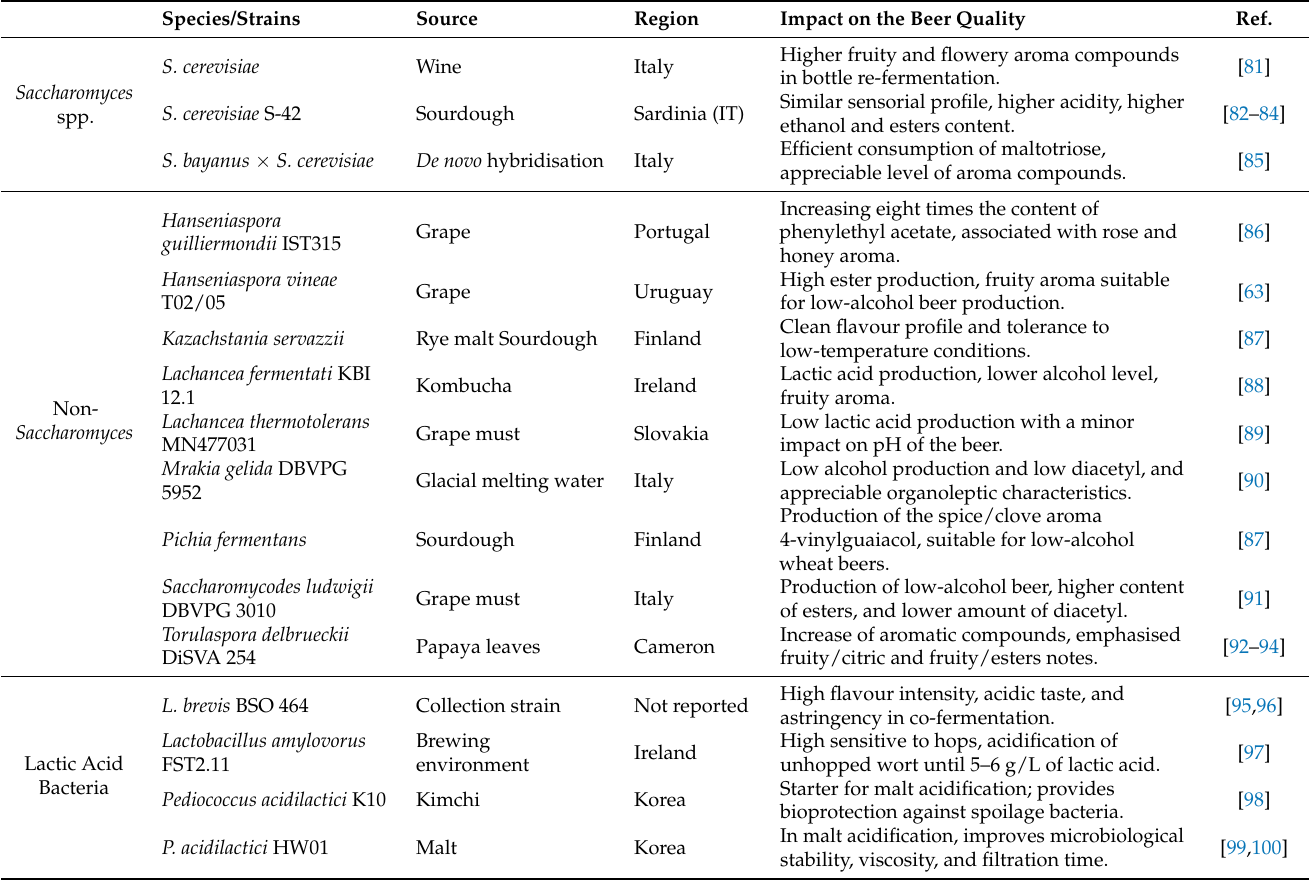
Table 3. Species, strains, origin, and impact of microbes recently investigated for their brewing potential. Species/Strains Source Region Impact on the Beer